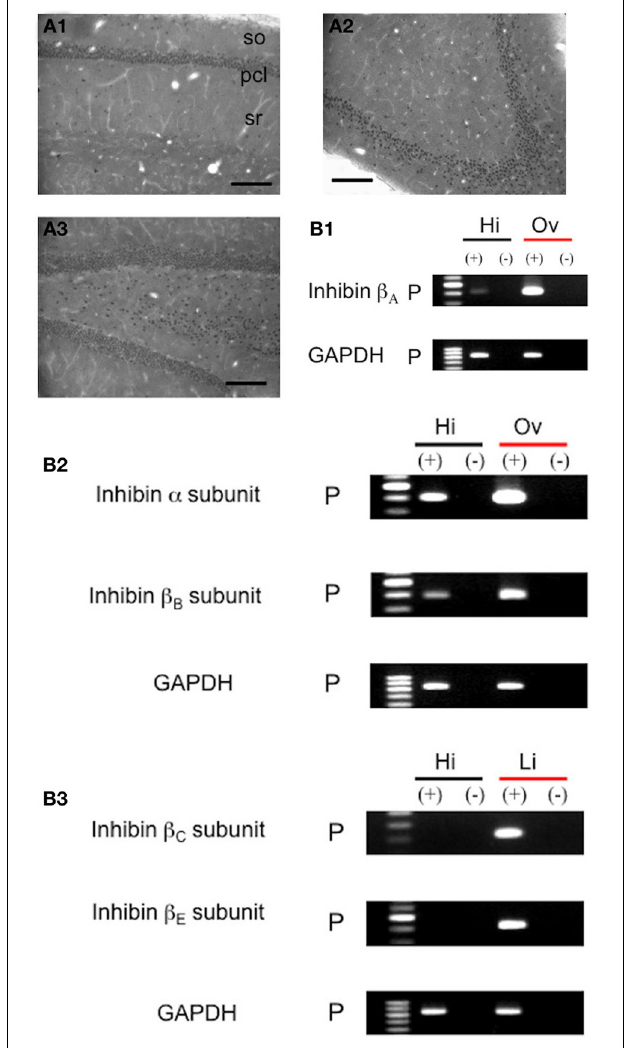
FIGURE 1 | Expression and localization of activin in the adult male rat hippocampus under physiological conditions. (A) Immunohistochemical staining of activin with anti-activin IgG. (A1) Coronal section of CA1 region. (A2) Coronal section of CA3 region. (A3) Coronal section of DG. so, stratum oriens; pcl, pyramidal cell layer; sr, stratum radiatum. Scale bar, 200 μ m. Representative images are shown from approx. 18 photographs from 6 independent slices from 3 animals. (Supplementary Figure 1A4) No staining after preadsorption treatments with activin. (B) RT-PCR analysis of mRNA for inhibin β A , α , β B , β C and β E subunits in the hippocampus (31 cycles). (B1) The expression of inhibin β A subunit transcripts. From left to right, size marker (Marker), hippocampus (Hi), ovary (Ov). (B2) Inhibin α and β β + ): with reverse transcriptase β B subunit. (B3) Inhibin C and E subunits. ( added; ( − ): without reverse transcriptase, a negative control. P: Ethidium bromide staining of PCR products. GAPDH (21 cycles) was used as an internal control for PCR amplification. Ovary (Ov) or Liver (Li) was used for positive control. The image is a representative one from duplicate determinations for each rat of total 4